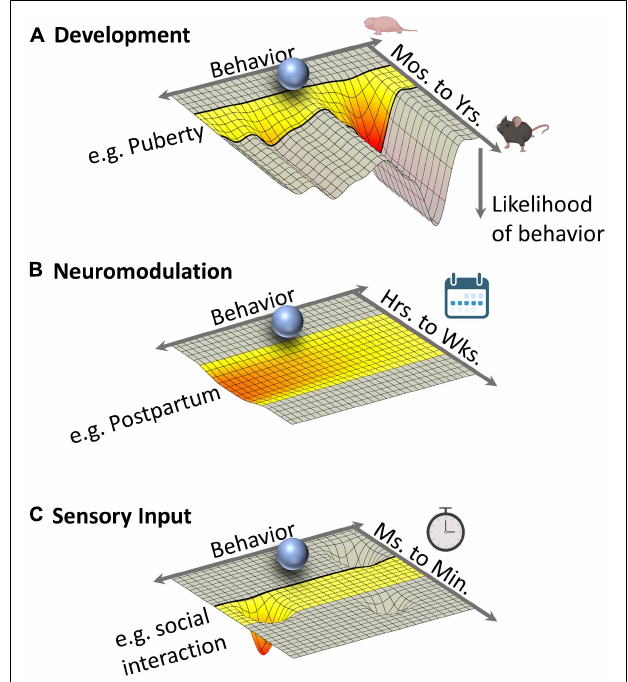
FIGURE 3 | Multiple Influences on the Energy Landscape of Social Circuit Function. Each energy landscape represents the probability of behavioral outcomes over three different timescales. Highlighted periods of time represent epochs during which circuit functions change, transiently or permanently, because of developmental, neuromodulatory, or sensory and interoceptive events. The depth of a given “energy well” is proportional to the likelihood of a specific behavior with deep troughs representing highly probably behaviors. Ultimately, the output of a social circuit represents the integration of these energy constraints. (A) Development. Puberty represents a developmental transition point during which the energy landscape of social circuits is dramatically reorganized to favor adult behaviors. The resulting energy landscape is, in large part, persistent through life. (B) Neuromodulation. Changes in neuromodulatory tone (e.g., steroid hormones or neuropeptides), such as those that occur during the postpartum period, persist for hours to weeks during which a subtle change to the energy landscape alters the likelihood of multiple behaviors. (C) Sensory input. Rapid fluctuations (milliseconds to minutes) in the energy landscape of social circuits are driven by dynamic and transient sensory and interoceptive input including the transduction of sensory cues during social interactions. Time symbols created with